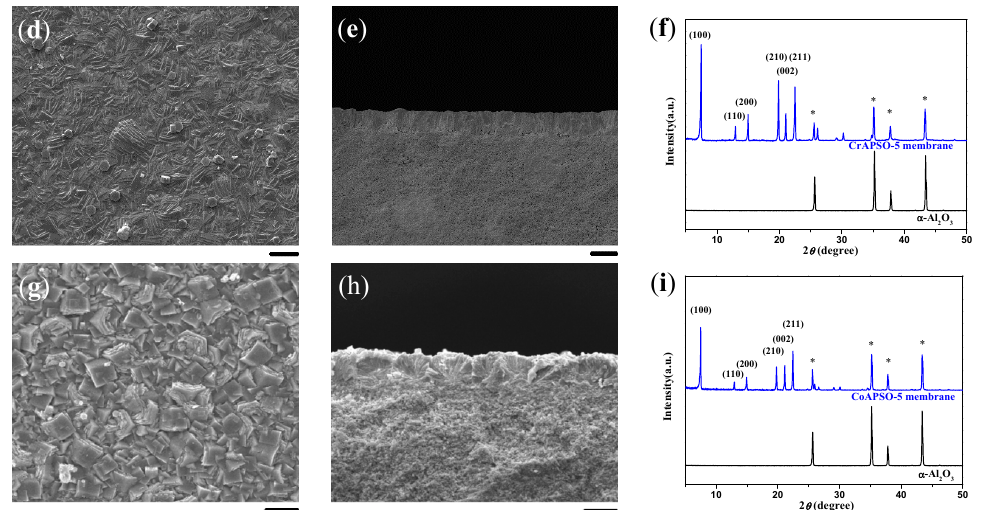
Figure 7. Top view and cross-sectional SEM images together with the corresponding XRD patterns for ( a – c ) SAPO-5, ( d – f ) CoAPSO-5, and ( g – i ) CrAPSO-5 membranes induced by a layer of LMW chitosan using pseudo-boehmite as the Al source. Scale bars correspond to 20 μ m in SEM images. The asterisks in the XRD patterns mark the peaks originating from α -Al 2 O 3 substrate.